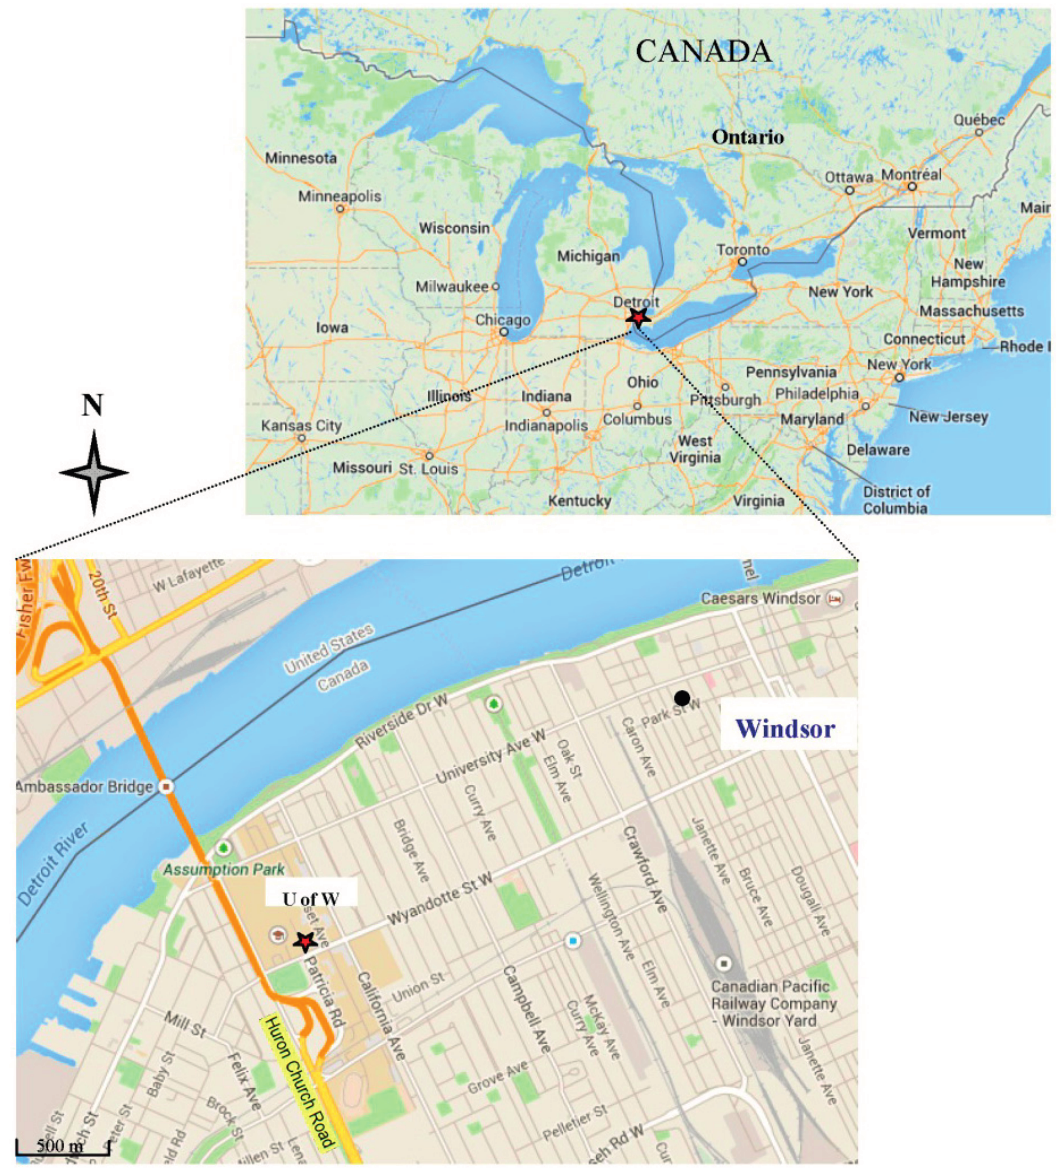
Figure 1. Map of sampling location ( ) at the University of Windsor, Ontario, Canada. ( represents Windsor Downtown Air Quality Station. Base maps adapted from Google